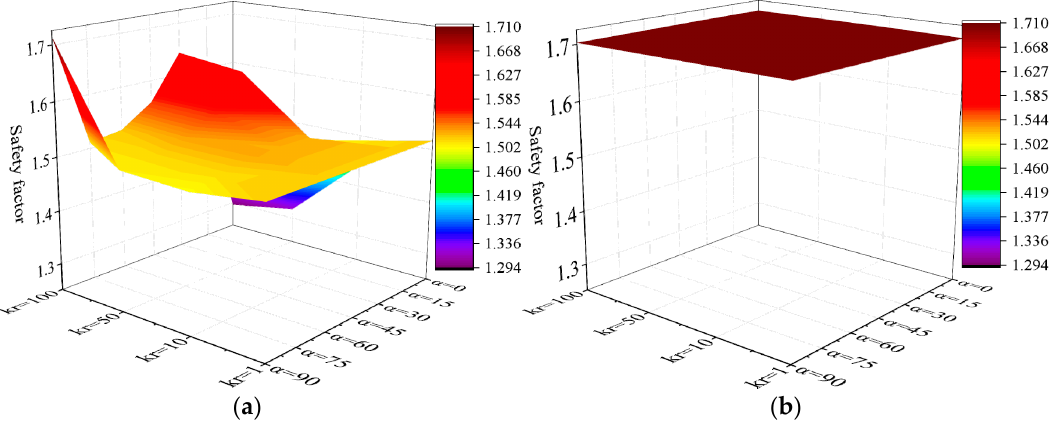
Figure 12. Variation of SF for clayey and sandy soil slope. ( a ) Sandy soil slope. ( b ) Clayey soil slope.